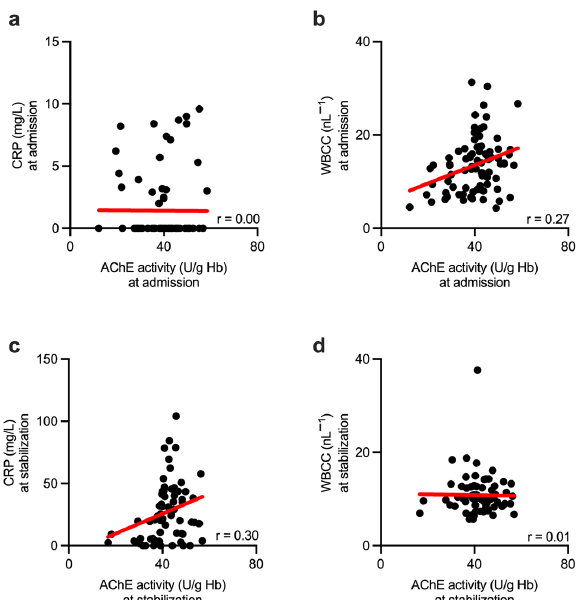
Figure 3. Conventional inflammatory biomarkers correlate with the AChE activity in a time-related manner. ( a ) AChE activity measured in injured patients at the hospital admission showed no correlation with (unaffected) CRP levels. ( b ) AChE activity correlated with WBCC when measured at the same time point. When measured at the time point of the secondary survey, 4–12 h following hospital admission (stabilization), AChE activity correlated with the CRP ( c ) but not WBCC ( d ). Dots represent single measurements. Red lines represent linear regression. AChE—acetylcholinesterase; CRP—C-reactive protein; WBCC—white blood cell count; r—Spearman correlation coefficient.